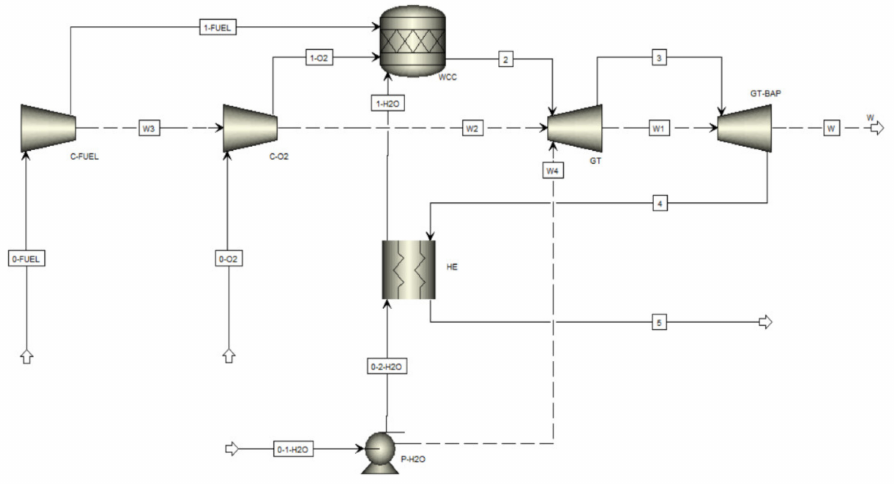
Figure 3. Simulation of PFD0 by Aspen Plus (0FUEL, 0O 2 , 01-H 2 O, 02-H 2 O, 1FUEL, 1O 2 , 1H 2 O, 2, 3, 4, 5—cycle nodal points).